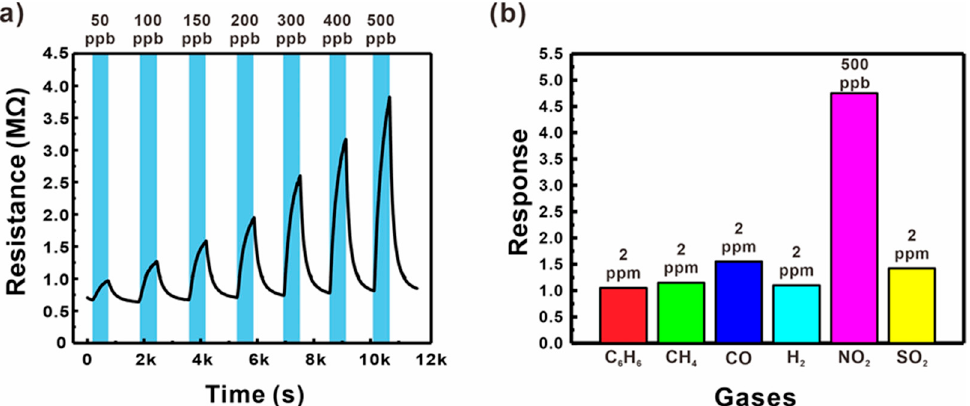
Figure 6. ( a ) Resistance changes of a suspended ZnO NW junction-based gas sensor (Type B) for various NO 2 gas concentrations (50–500 ppb) mixed in dry air. ( b ) Responses of a suspended ZnO NW junction network-based sensor (Type B) to C 6 H 6 , CH 4 , CO, H 2 , NO 2 , and SO 2 gases mixed in dry air.